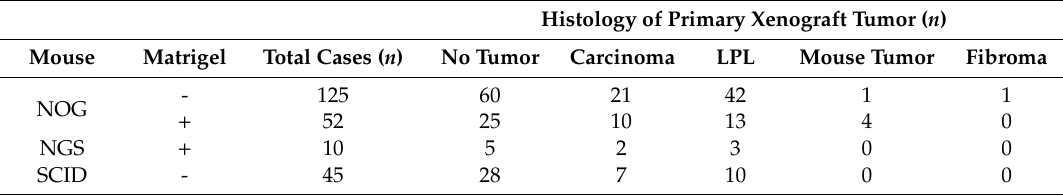
Figure 6. Histology and immuno-molecular phenotypes of lymphoproliferative lesions. The majority of mononuclear cells with moderate nuclear atypia were CD20-positive. They were positive for human Chromosome 17 probes but negative for EBER. A representative case is shown. Table 5. Outcomes of engrafted gastric cancer tissue in NOG, NSG, and SCID mice.